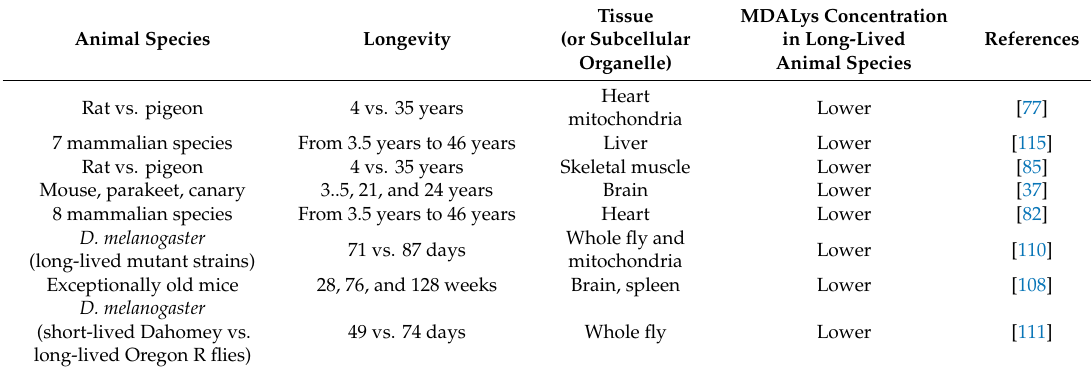
Table 4. Relationship between lipoxidative damage measured as MDALys by GC / MS and animal longevity. Animal